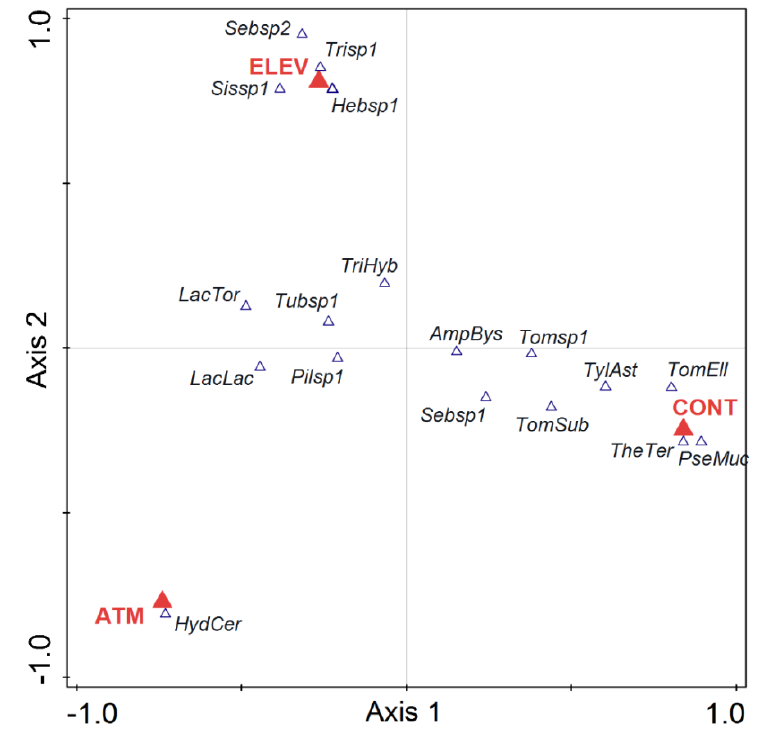
Figure 2. Canonical correspondence analysis diagrams showing the occurrence of morphotypes on the P. abies roots related to the site-glass domes at ambient CO 2 level (ATM) or elevated CO 2 level (ELEV) and in an unenclosed control (CONT) at the Bílý Kříž site. Species abbreviation: AmpBys, Amphinema byssoides ; Hebsp1, Hebeloma sp. 1; Hydcer, Hydnotrya cerebriformis ; LacLac, Laccaria laccata (Scop.) Cooke ; LacTor, Laccaria tortilis (Bolton) Cooke; Pilsp1, Piloderma sp. 1; PseMuc, Pseudotomentella mucidula ; Sebsp1, Sebacina sp. 1; Sebsp2, Sebacina sp. 2; Sissp1, Sistotrema sp. 1; TheTer, Thelephora terrestris ; TomSub, Tomentella sublilacina (Ellis & Holw.) Wakef.; Tomsp1, Tomentella sp. 1; TomEll, Tomentella ellisii ; Trisp1, Trichophaea sp. 1; TriHyb, Trichophaea hybrida ; Tubsp1, Tuber sp. 1; TylAst, Tylospora asterophora